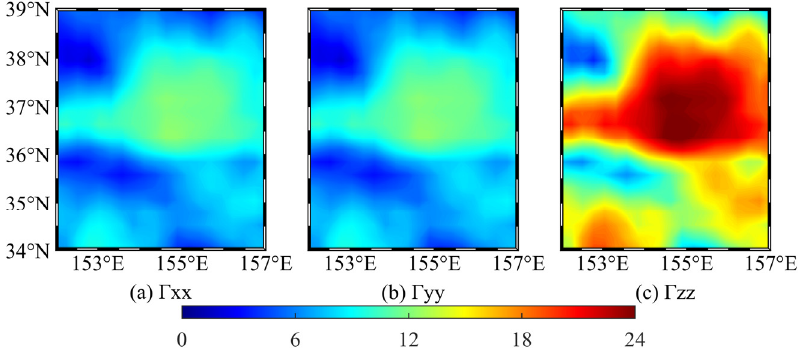
Figure 9. Annual range of sea level anomalies in the study area (unit: m).